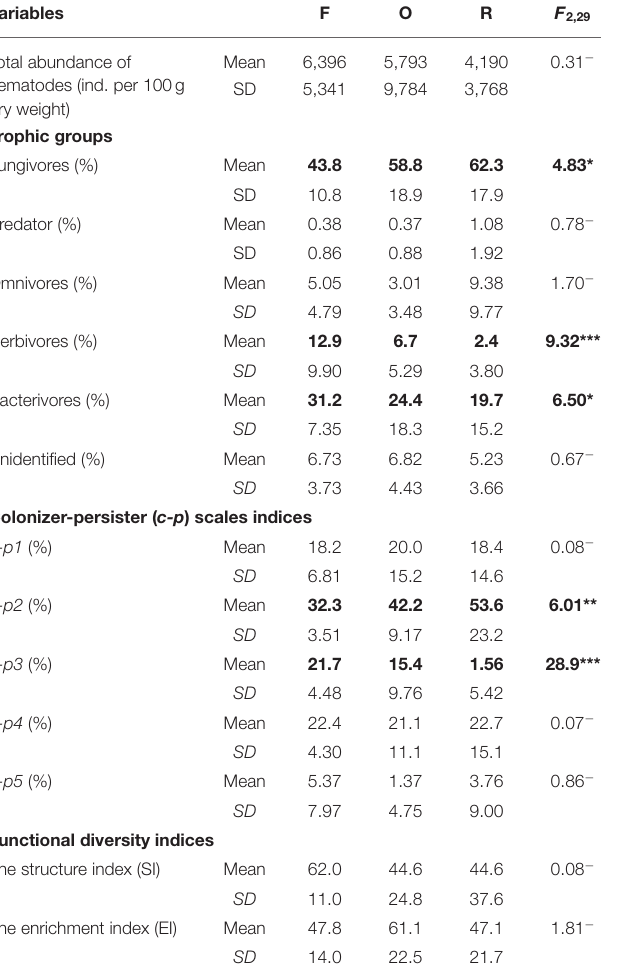
TABLE 3 | Mean, SD , and F - and p -values for land use and riparian sites in soil. Variables